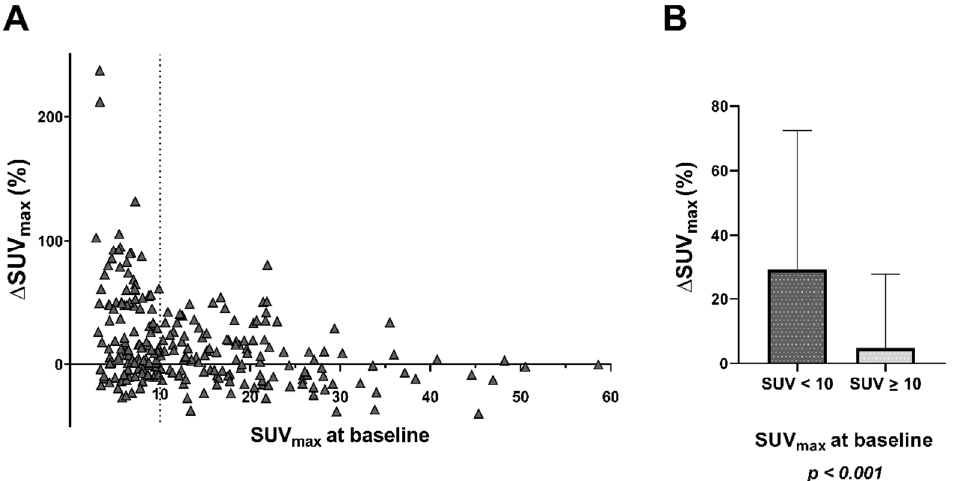
Figure 6. Relative change of SUV max in 242 bone metastases (maximum of 10 per patient) after enzalutamide medication ( A ) for each lesion individually, ( B ) categorized in subgroups with initial SUV max < 10 and SUV max ≥ 10,